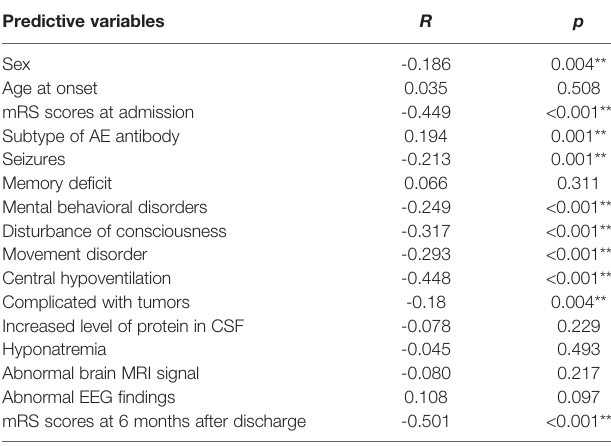
TABLE 3 | Correlation analysis of possible factors for low T3 syndrome in patients with autoimmune encephalitis (n=237). Predictive